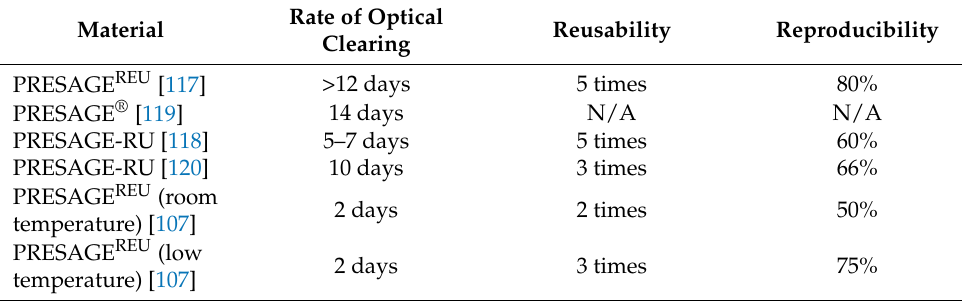
Table 4. Reusability and reproducibility of